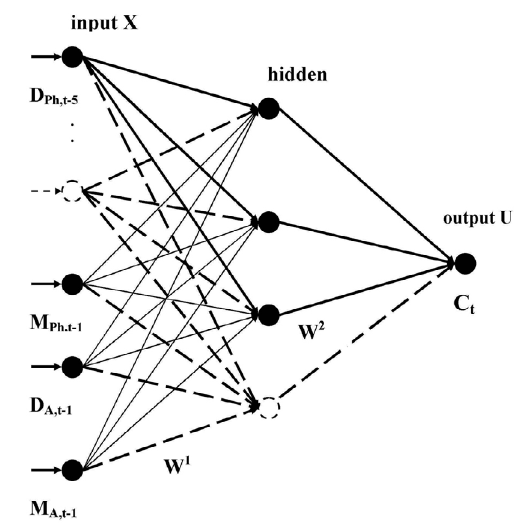
Figure 1. Three layer perceptron of back-propagation neural net- work applied to prediction of seismic events. The input signal rep- resents the mean and dispersion values of the phases (M , respectively) and amplitudes (M D Ph,t-n in the nighttime for five days before the seismic event ( n varies from 1 to 5). The corresponding level of correlation with the seismic is used as the output event C t